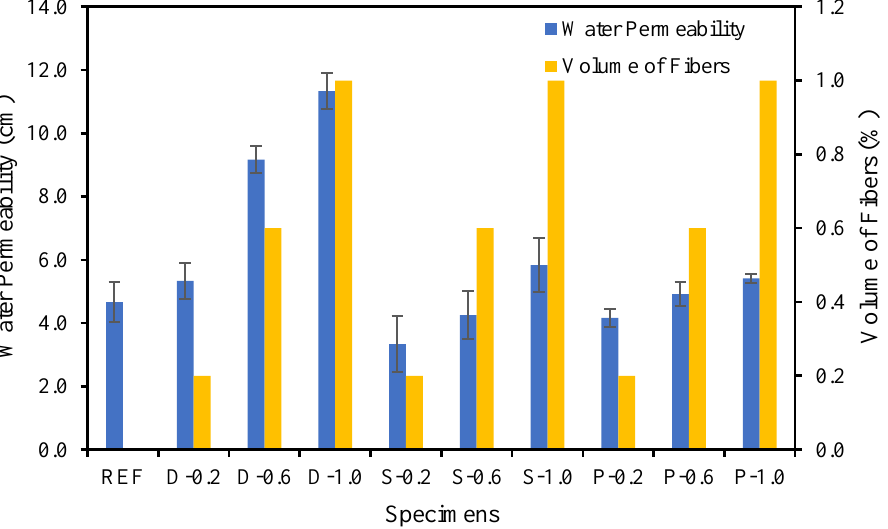
Figure 14. Different fibers influence on the water permeability of fibrous concrete samples. The relationship between the water permeability of high-strength concrete and volume fractions of date palm, steel, and polypropylene fibers is shown in Figure 15. The curves have revealed that the water permeability of the date palm fibrous-reinforced high-strength concrete steeply increases with the fibers’ volume fractions. Contrastingly, steel and polypropylene fibrous-reinforced high-strength concrete follow the slowly growing trend of adding fibers to concrete. The following equations might predict the water permeability of the high-strength date palm, steel, and polypropylene fibrous concrete.